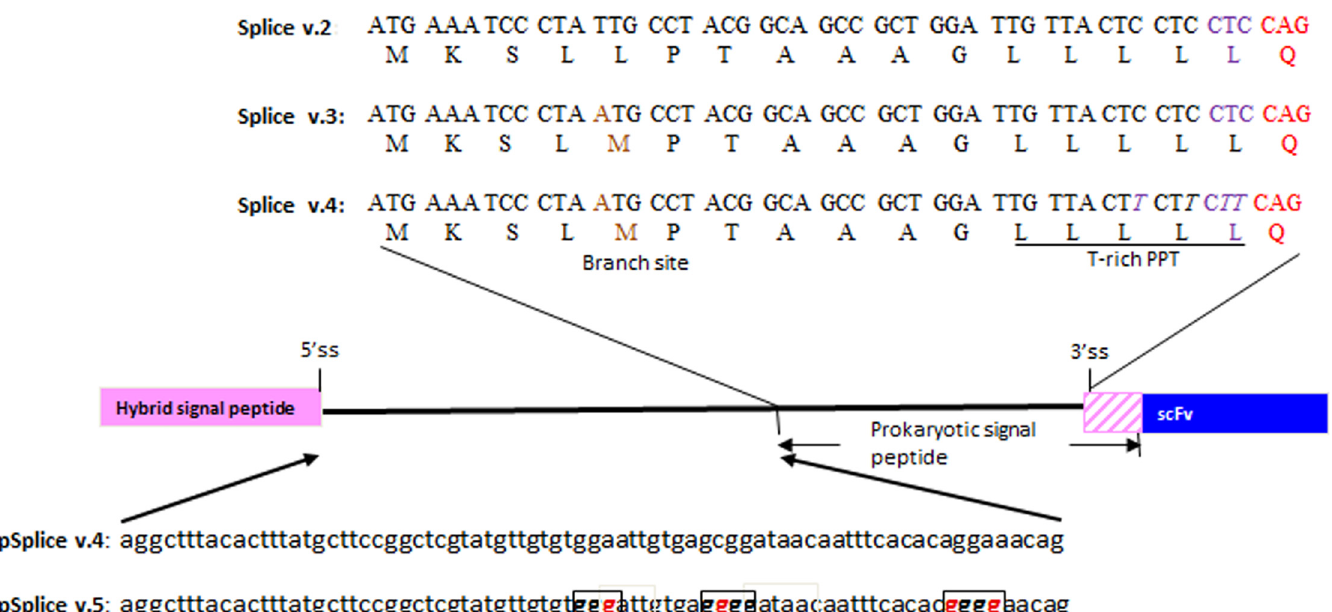
Fig 2. Upper panel: Codons and corresponding amino acids of pelB signal sequence showing splicing signal modifications in different versions of pSplice vectors. Introduction of branch point is indicated in brown. Introduction of the T-rich polypyrimidine tract (PPT) is shown in purple italic letters. Lower panel: Regions of engineering poly-G runs around -10 nucleotide of lac promoter are indicated by red letters in boxes.